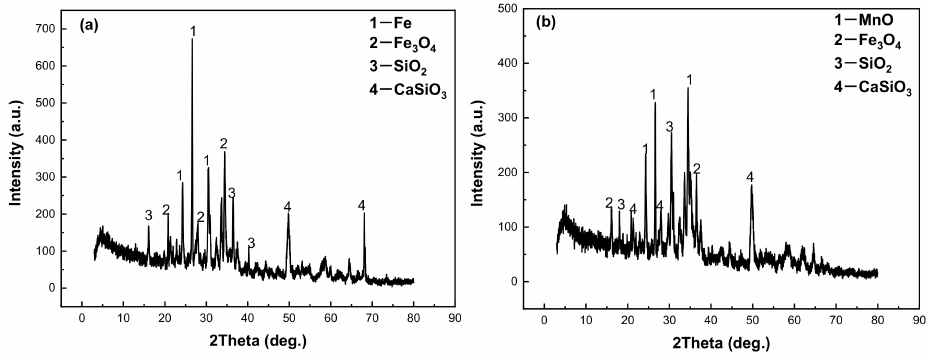
Figure 8. X-ray diffractogram of iron concentrate ( a ) and manganese concentrate ( b